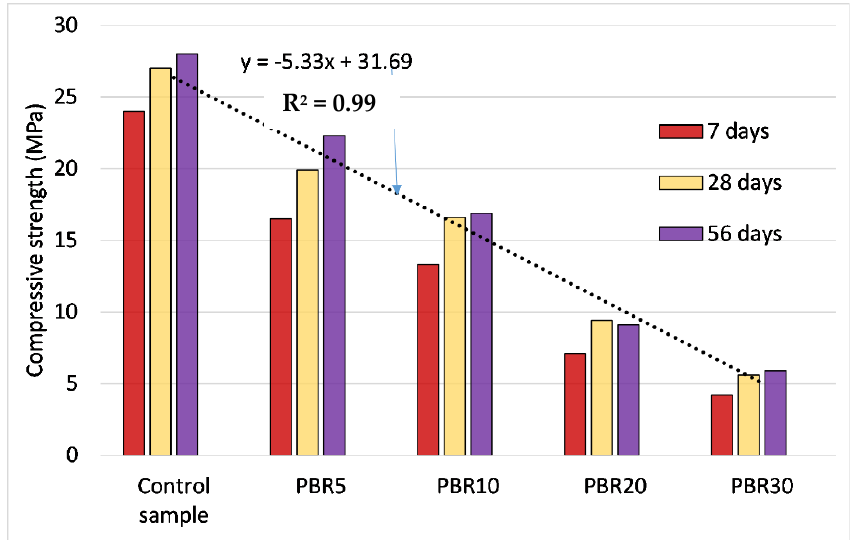
Figure 5. Compressive strength of CR IPB at 7, 28 & 56 days (Trendline for 28 days).